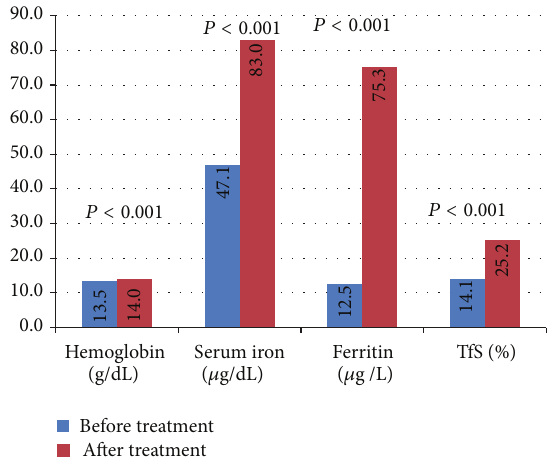
Figure 1: Mean hematologic parameters before and after intra- venous FeS treatment.